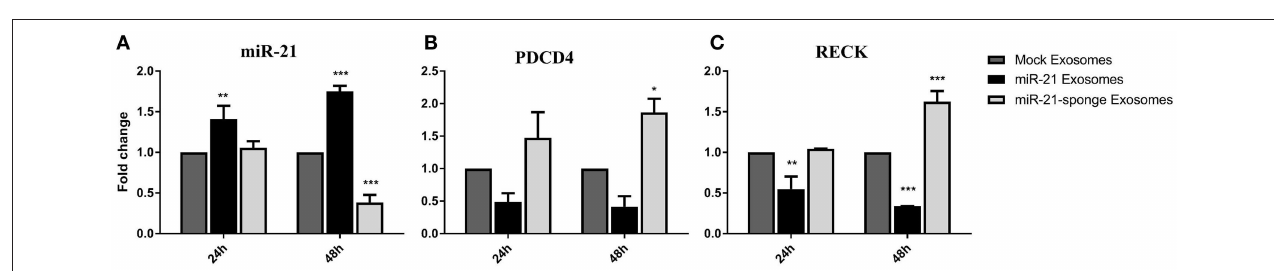
FIGURE 4 | Altered expression of miR-21 and its target genes in U87-MG cells exposed to engineered exosomes. (A) A significant elevation of miR-21 level in U87-MG cells exposed for 24 or 48h to the exosomes obtained from pri-miR-21 expressing HEK-293T stable cells (miR-21 enriched exosomes), along with a downregulation of miR-21 in the cells treated with exosomes obtained from the miR-21-sponge expressing HEK-293T stable cell line (miR-21-sponge containing exosomes). The expression levels of miR-21 target genes PDCD4 (B) and RECK (C) revealed their expected downregulations in the cells exposed to miR-21 enriched exosomes and their upregulations in the cells exposed to the miR-21-sponge containing exosomes, at 24 and 48h after the treatments. Exosomes obtained from mock-vectors transfected HEK-293T stable cell lines were used as controls to normalized the levels of gene expressions. * P < 0.05, ** P < 0.01, *** P < 0.001, which is represented by some statistical software like Graph Pad.